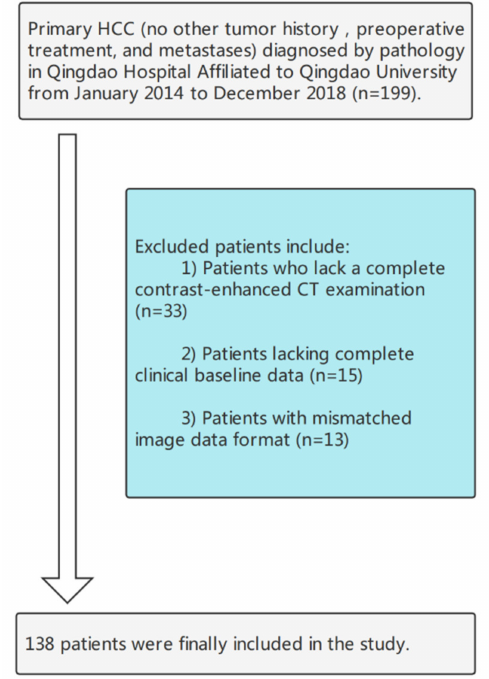
Figure 2. The flowchart of the patient selection